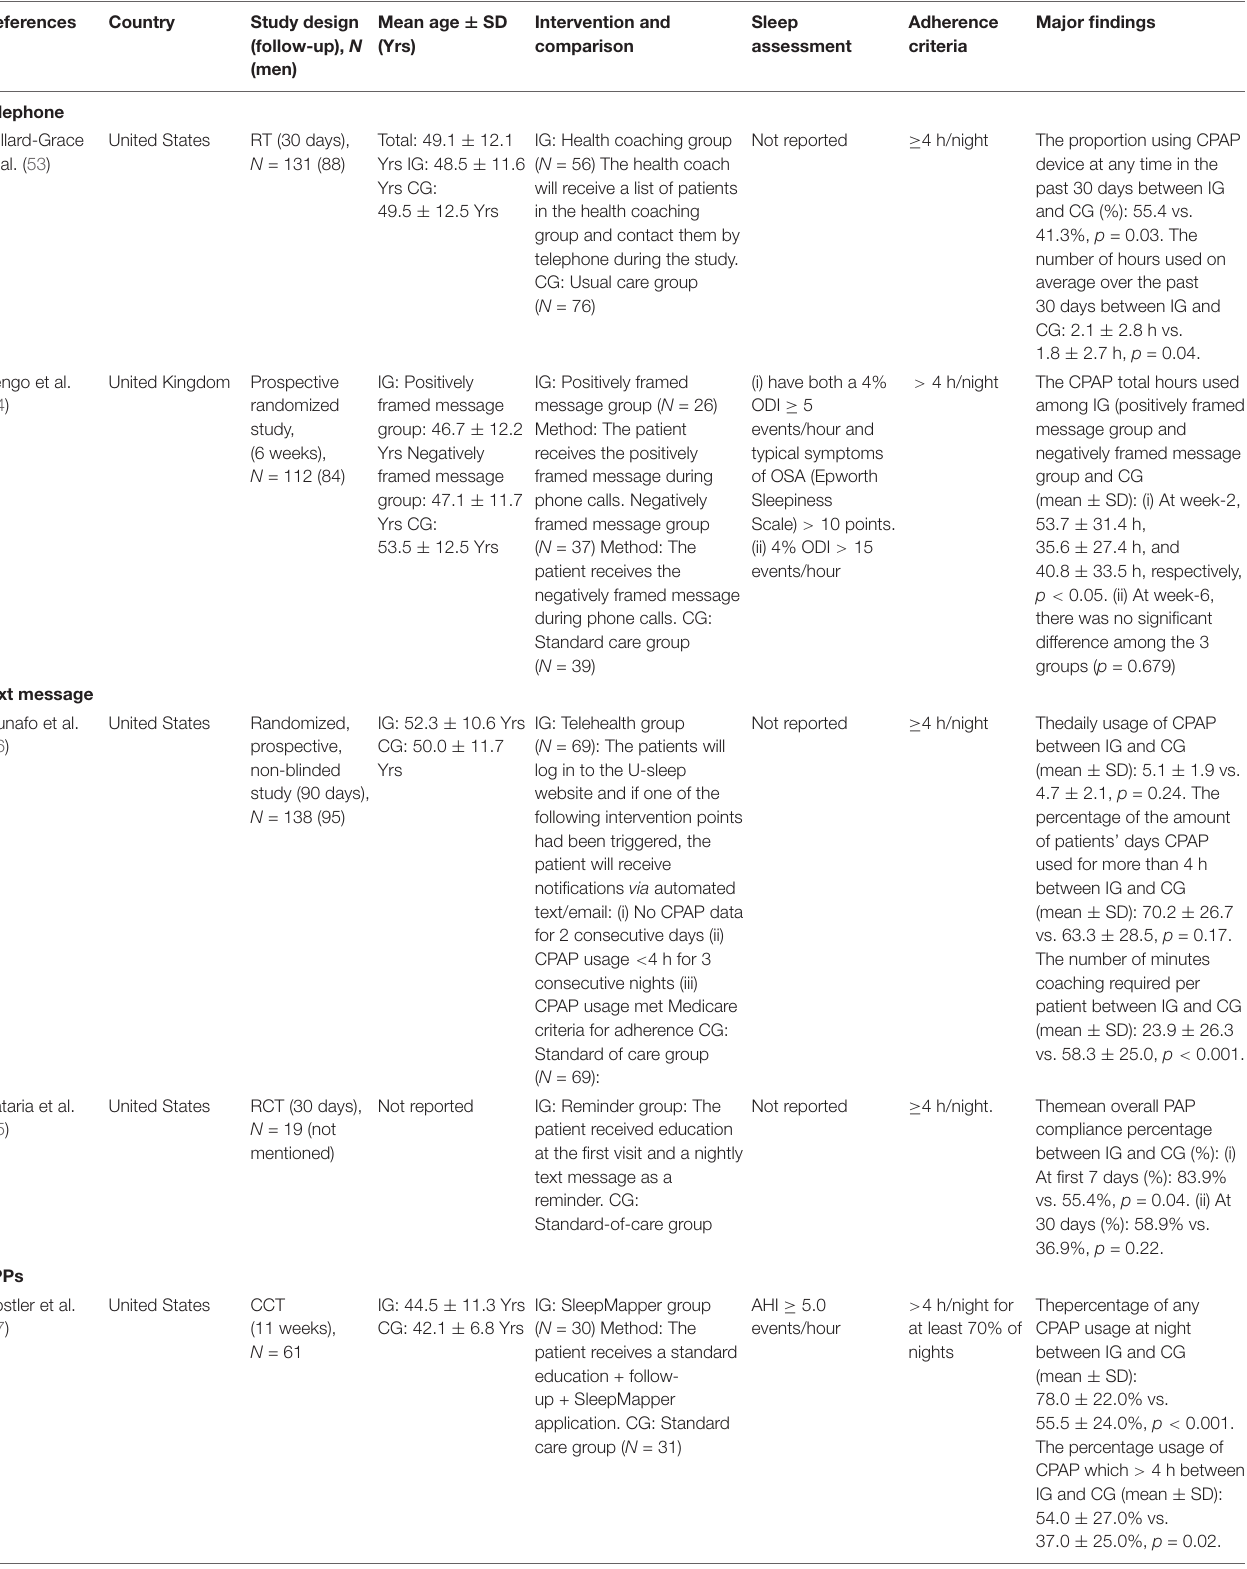
TABLE 2 | Summary of telehealth